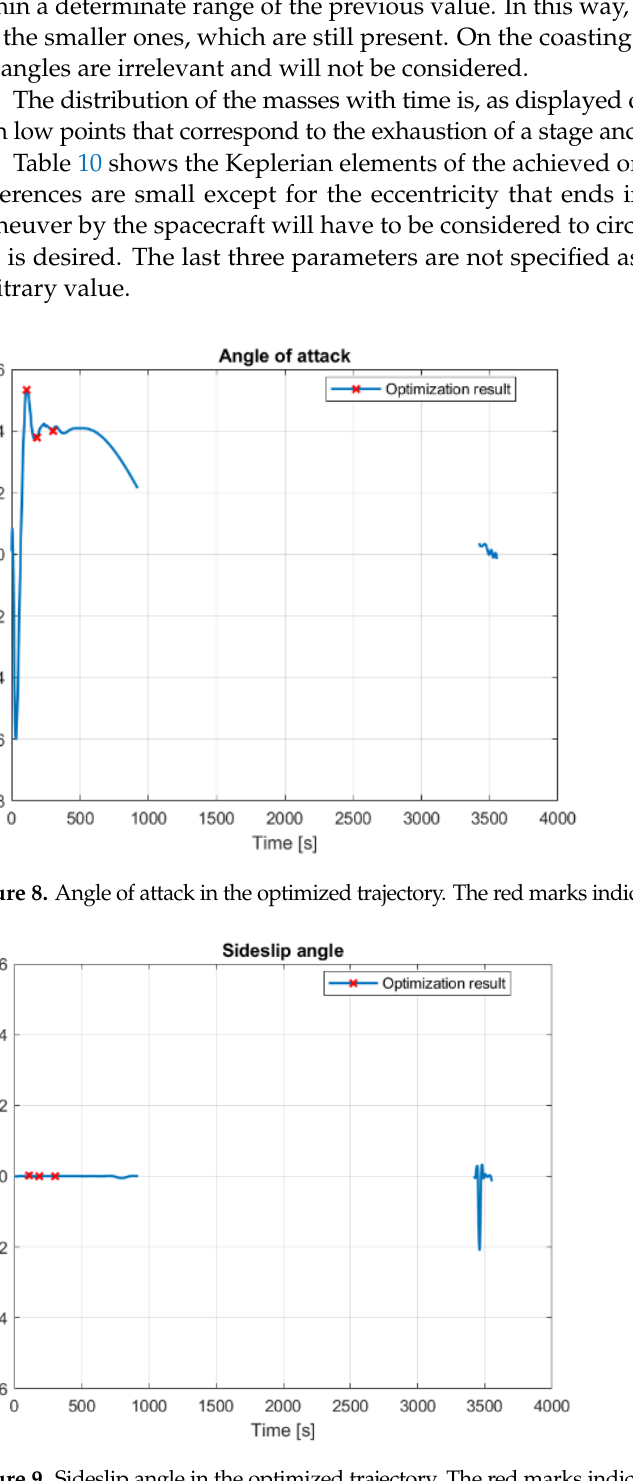
Figure 7. Flight path angle in the optimized trajectory. The red marks indicate the staging or coasting phase.